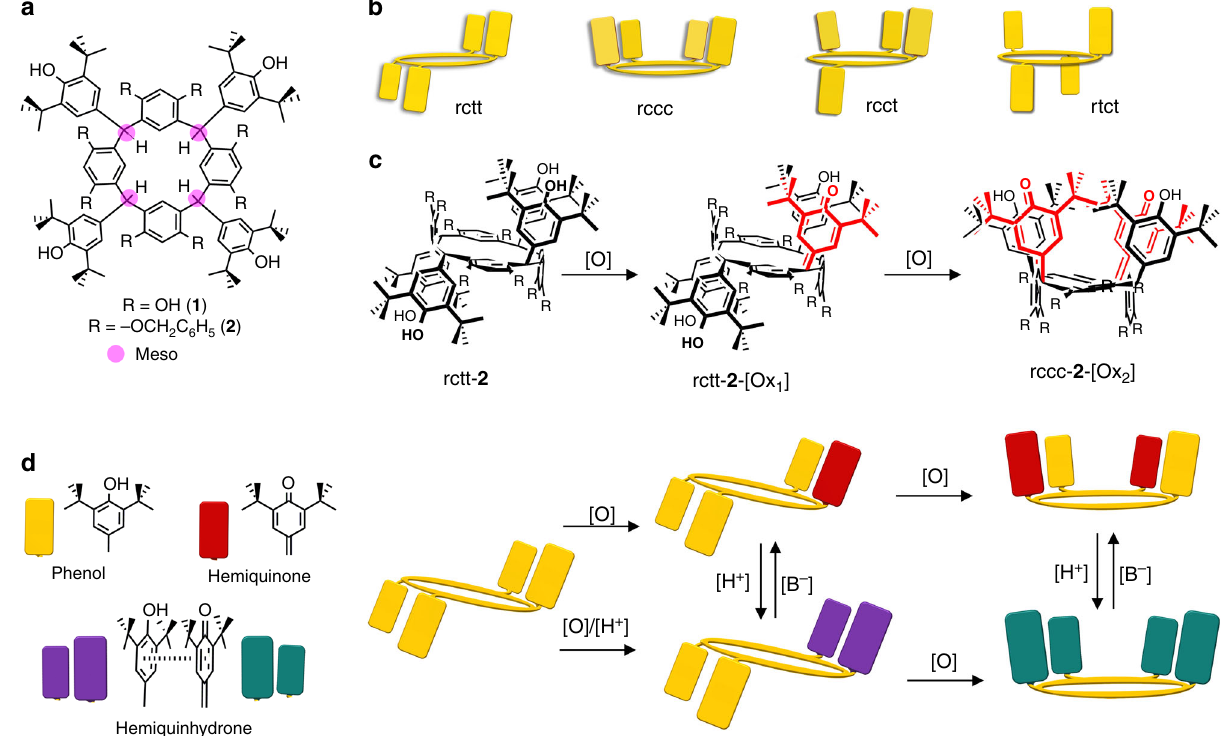
Fig. 2 Structures and graphical representation of the compounds. a Chemical structures of 1 and 2 prepared in this work. b Common possible isomers of resorcinarene based on the relative conformations of substituents. c Chemical structures of compounds in the 2 series: rctt- 2 , rctt- 2 -[Ox 1 ] and rccc- 2 - [Ox 2 ] obtained by stepwise oxidation with 2,3-dichloro-5,6-dicyano-1,4-benzoquinone (DDQ). Identity of the hemiquinonoid substituents is denoted by red in the line drawings. d Graphical representation of transformations of 2 involving oxidation of phenol groups (yellow blocks) to hemiquinonoid (red blocks), and quinhydrone activity of the resulting compounds denoted by purple for rctt- 2 -[Ox 1 ] and turquoise for rccc- 2 -[Ox 2 ]. [O] denotes oxidation; [H + ] and [B − ] denote acid and base,